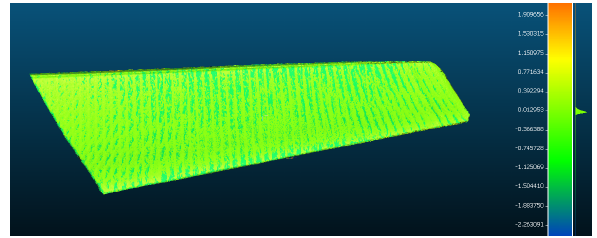
Figure 6. Results of measurement comparison for two sets of the calibration